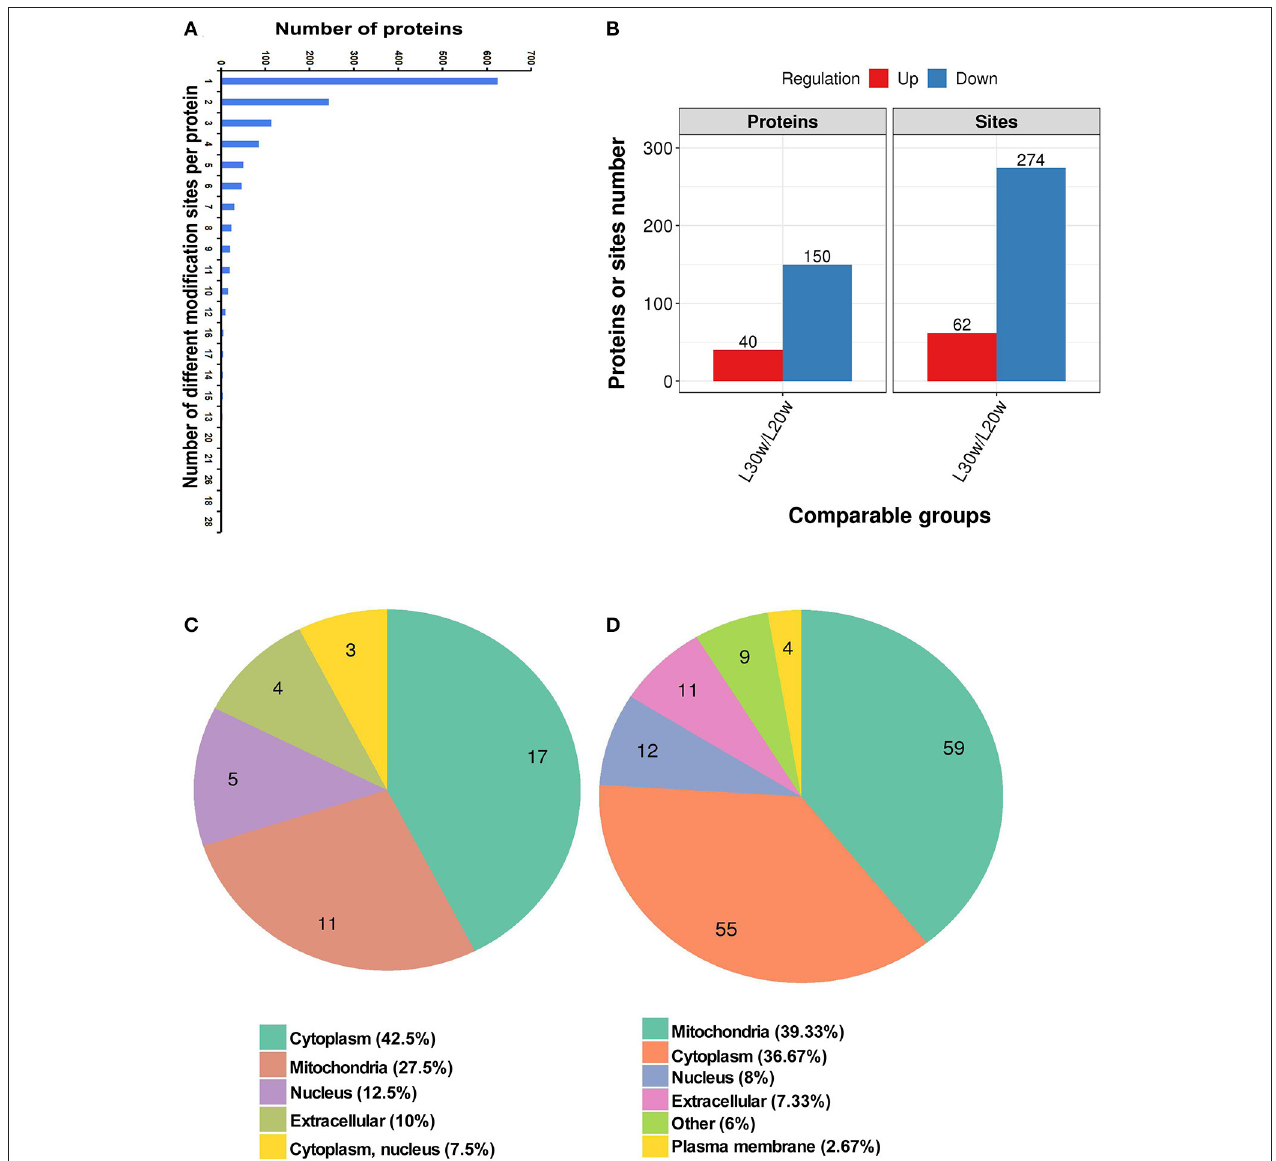
FIGURE 4 | Identification and functional enrichment of lysine-acetylated proteins. (A) Distribution of acetylated lysine site in corresponding proteins. (B) Numbers of acetylated lysine site and corresponding proteins. (C) Subcellular localization of differentially upregulated kac proteins. (D) Subcellular localization of differentially downregulated kac